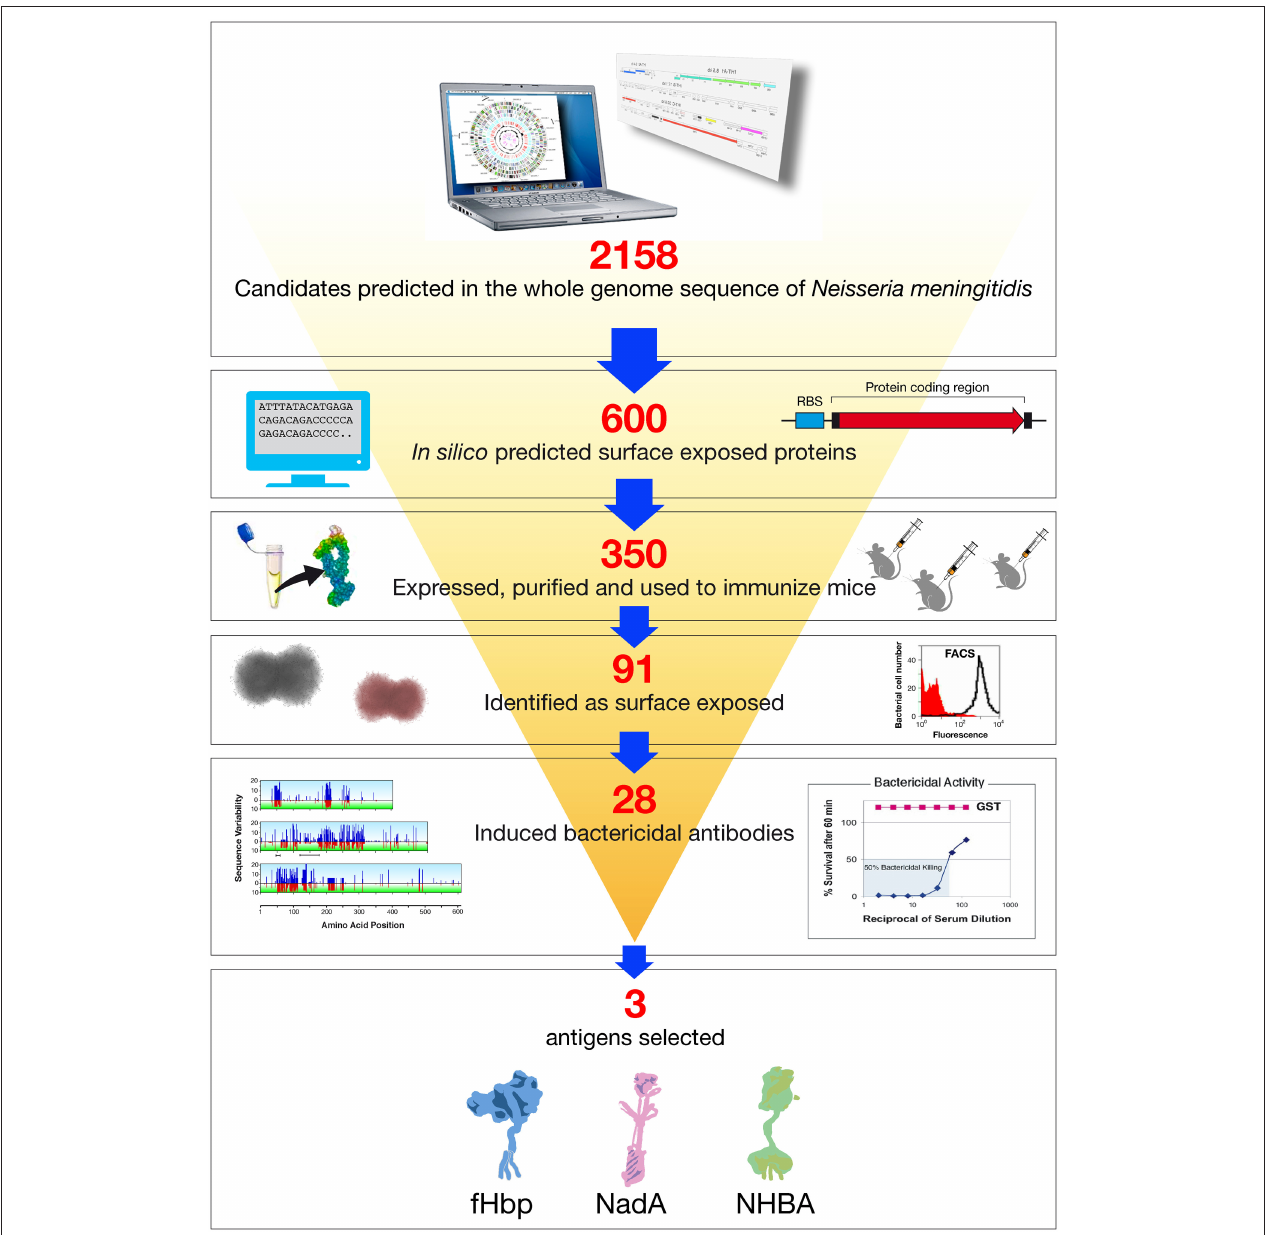
FIGURE 2 | Reverse vaccinology applied to Neisseria meningitidis B. Based on the complete genome sequence of N. meningitidis strain MC58, 2158 potential open reading frames (ORFs) were identified. In silico analysis resulted in the selection of 600 genes potentially encoding for novel surface exposed proteins. These were amplified by PCR and cloned into Escherichia coli expression vectors. Three hundred and fifty recombinant proteins were successfully produced, purified, and used to immunize mice. Recombinant protein candidates were then selected based on their surface expression (assessed by FACS), and ability to induce serum bactericidal antibodies (assessed by the SBA serum bactericidal assay) and conservation in a panel of Neisseria strains. The antigens selected by reverse vaccinology were finally prioritized, with NadA, fHbp, and NHBA as the three top